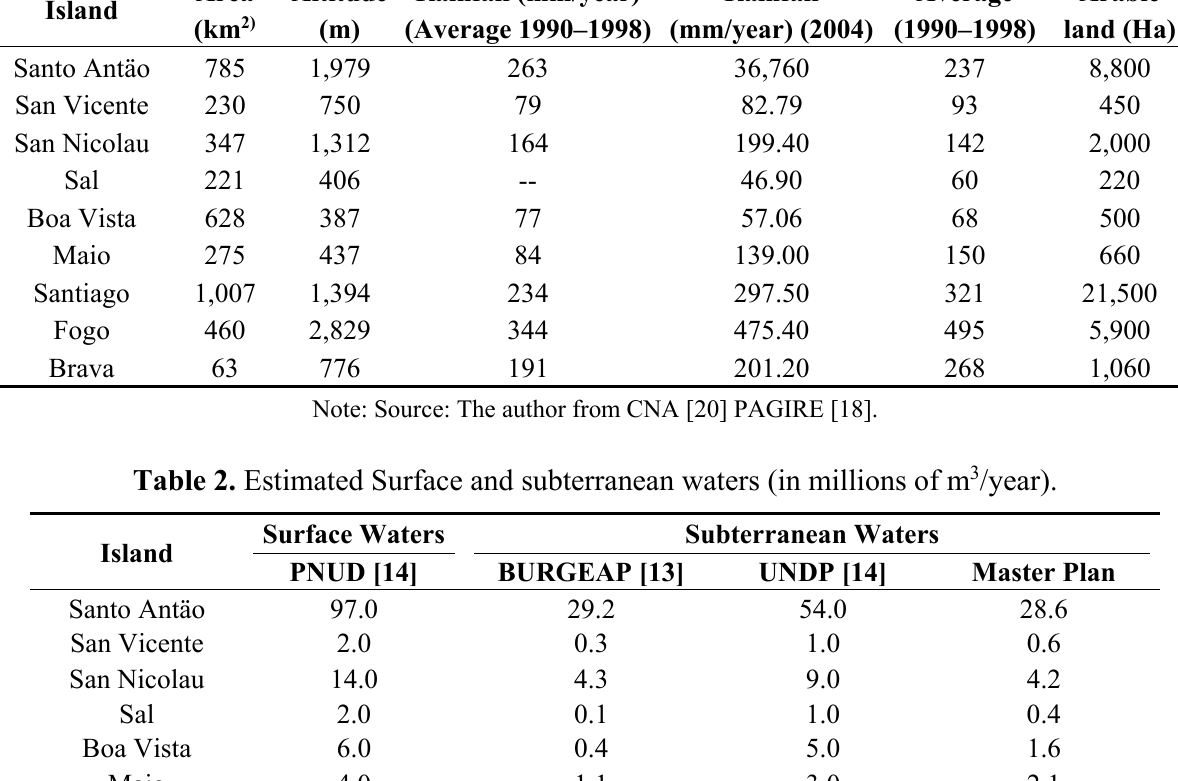
Table 1. Physical characteristics and rainfall in Cape Verde (averages). Island